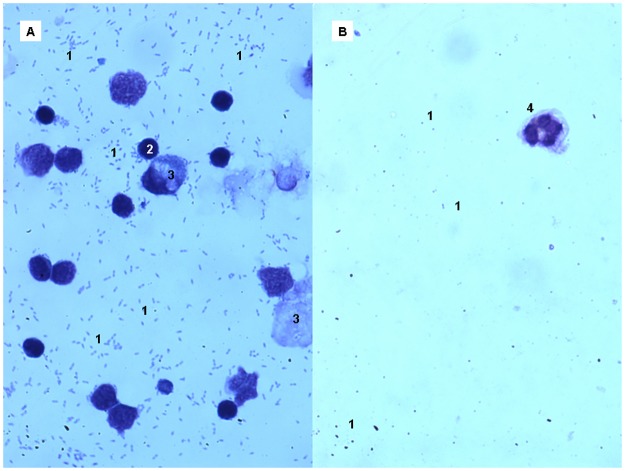
Optical microscopy observation of milk samples from a woman with presumptive signs of “mammary candidiasis” (A), and from another women without painful breastfeeding (B).1, Staphylococcus epidermidis cells; 2, T cells; 3, epithelial cells; 4, polymorphonuclear neutrophil. Note the absence of yeasts’ cells.